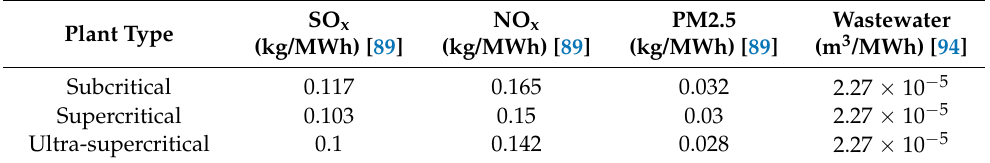
Figure A1. Environmental Pollution Tax rates for selected pollutants by province. Units: CNY/kg (CNY/m 3 for wastewater). Table A14. Coal plant local pollutant emissions by plant type.